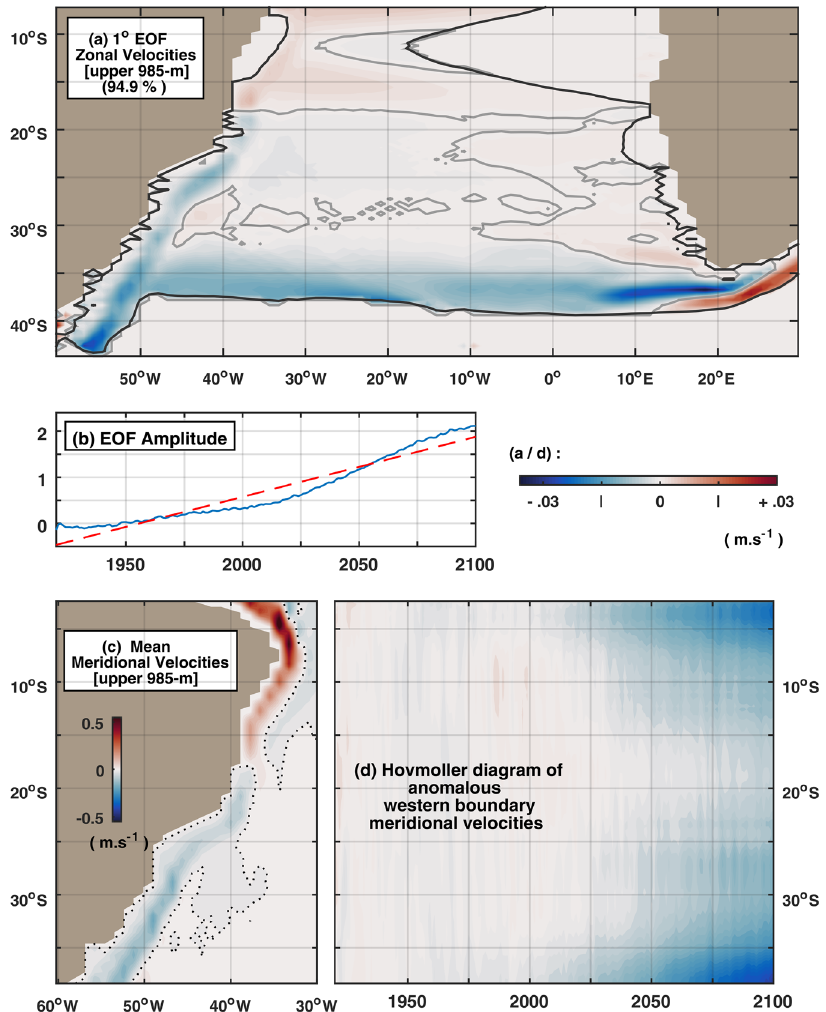
Fig. 4 Changes in the distribution of zonal and meridional SASG fl ows. a Spatial pattern of the leading EOF (94.9% of total variance) of zonal velocity anomalies along 1920 – 2100 within the upper 985-m of the South Atlantic subtropical gyre (delimited by the 1920 – 2100 mean zero zonal velocity line — black fi lled contour). Trends were not removed from the data prior to performing the EOF. b Corresponding dimensionless amplitude, or Principal Component (PC), time series (blue) and its linear trend along 1920 – 2100 (red dashed line). c 1920 – 2100 mean, upper 985-m, meridional velocities along the SA western boundary, showing thenorth-southdistribution of the WBCs, for reference. d Hovmoller diagramofanomalous meridionalvelocities averagedoverthewestern boundary layer (within a 6 ∘ -longitude band off the South American coast), corresponding to the meridional extension in c